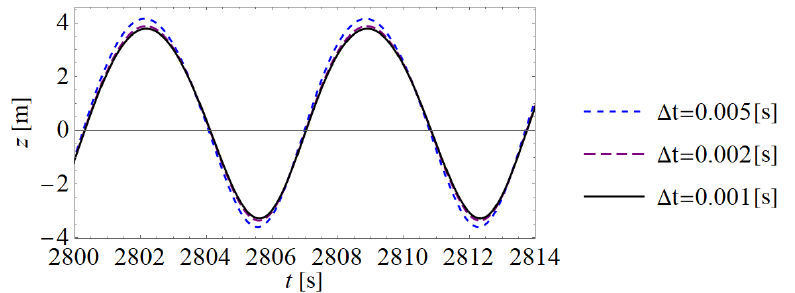
Figure 10. Steady-state oscillations for various integration step sizes (wave parameters: H = 2.2 [m], ω = 1.87